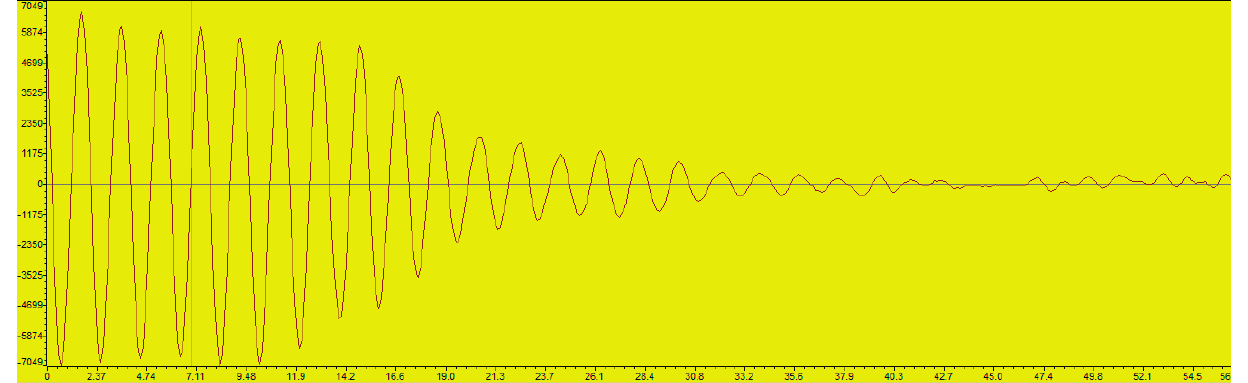
Figure 9. SAW resonator response signal (the horizontal axis is time in microsecond, and the vertical axis is the digitalized amplitude).